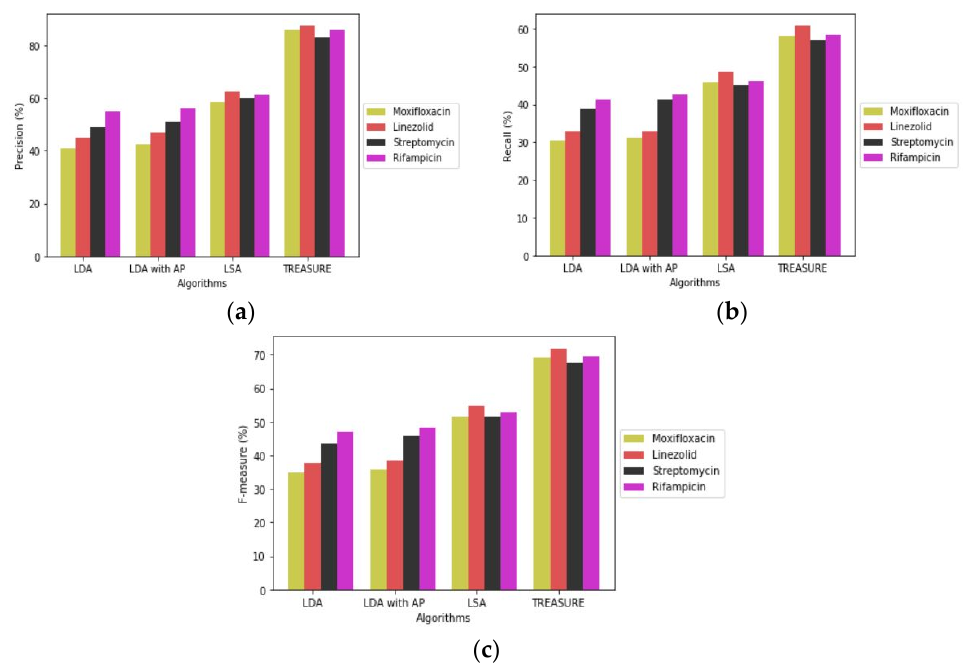
Figure 6. Comparison of various algorithms for the following measures: ( a ) precision; ( b ) recall; ( c ) F-measure.